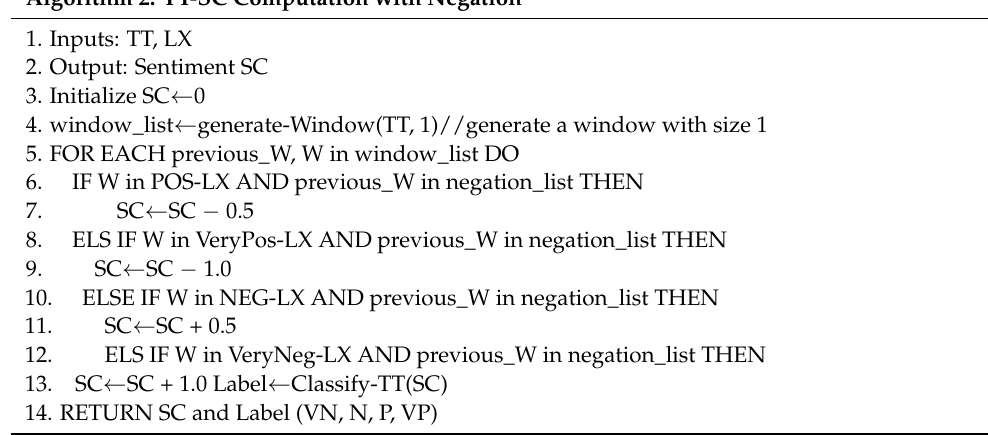
Algorithm 2: TT-SC Computation with Negation